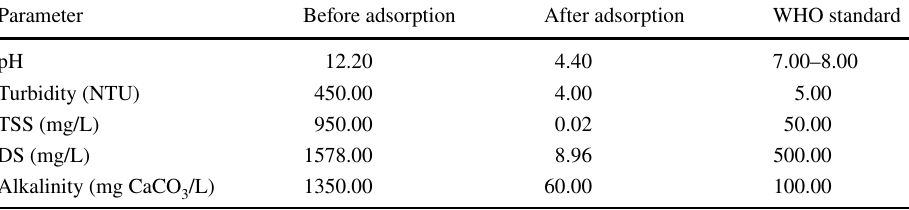
Table 4 Results of the characterization of fibre cement effluent before and after